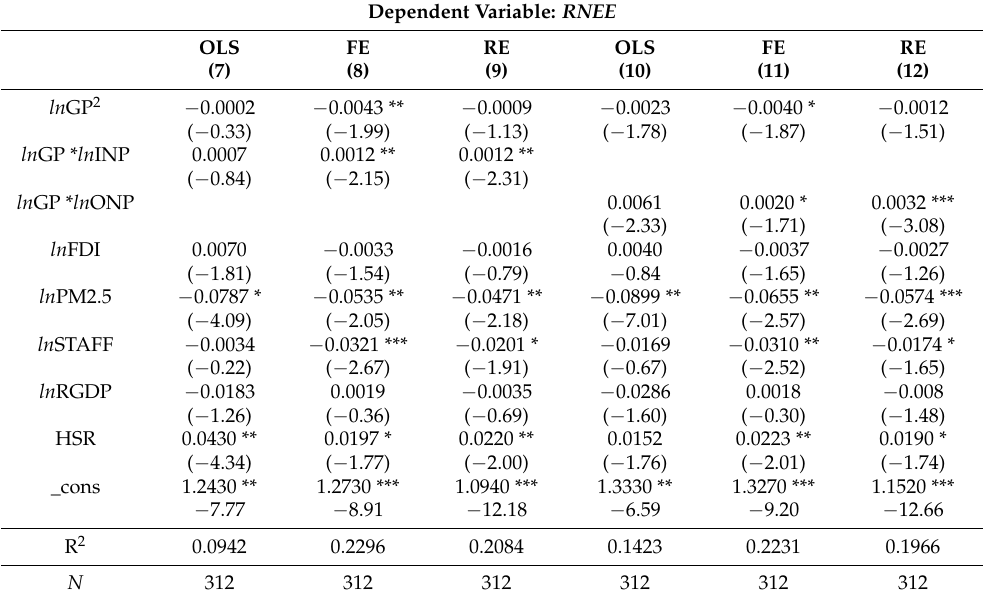
Table 3. Econometric results on the impact of multi-dimensional proximity interactions on urban